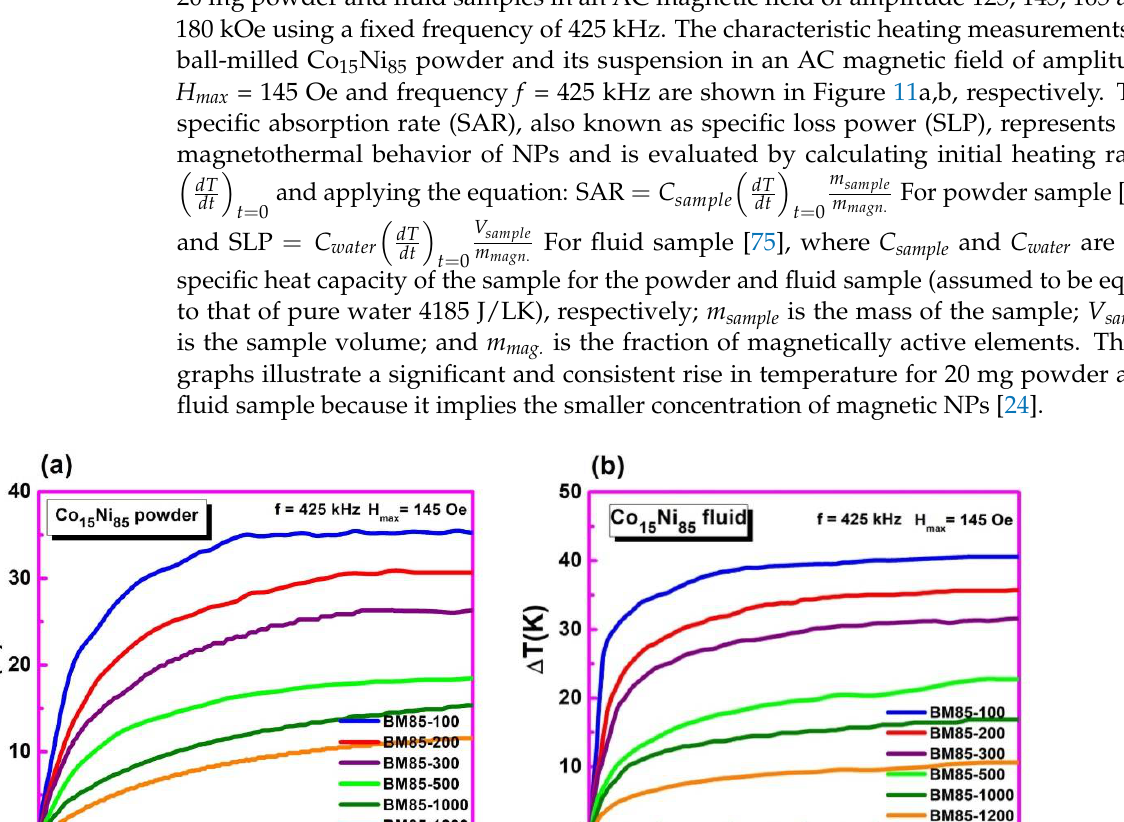
Figure 10. Curie temperature against Ni content and crystallite size for ( a ) Co 100−x Ni x NPs as a func- tion of Ni content and for ( b ) Co 15 Ni 85 NPs milled at a speed of 1425 rpm for 100, 200, 300, 500, 1000 and 1200 min.